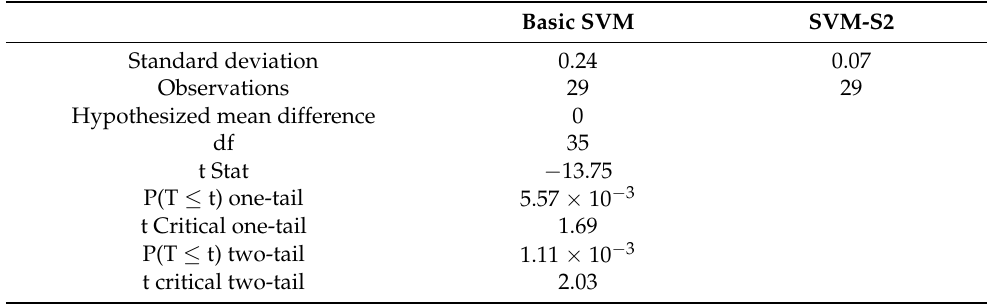
Table A6. t -Test: two-sample assuming unequal variances between basic SVM and SVM-S2, RC beam.